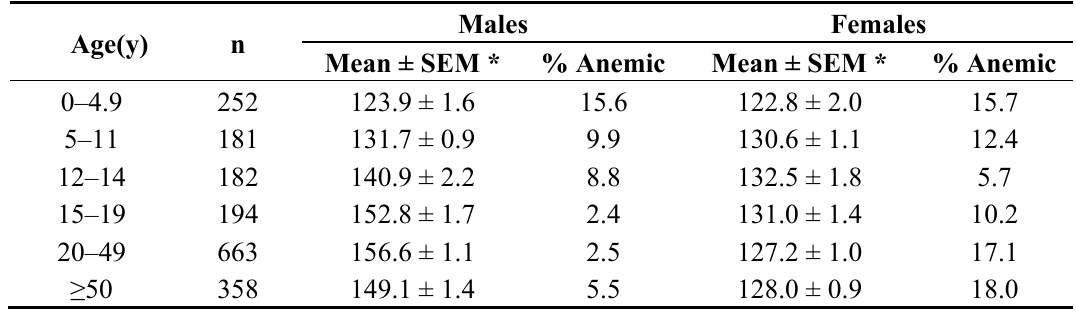
Table 1. Mean Kuwaiti Hb concentration and percent anemic by gender and age